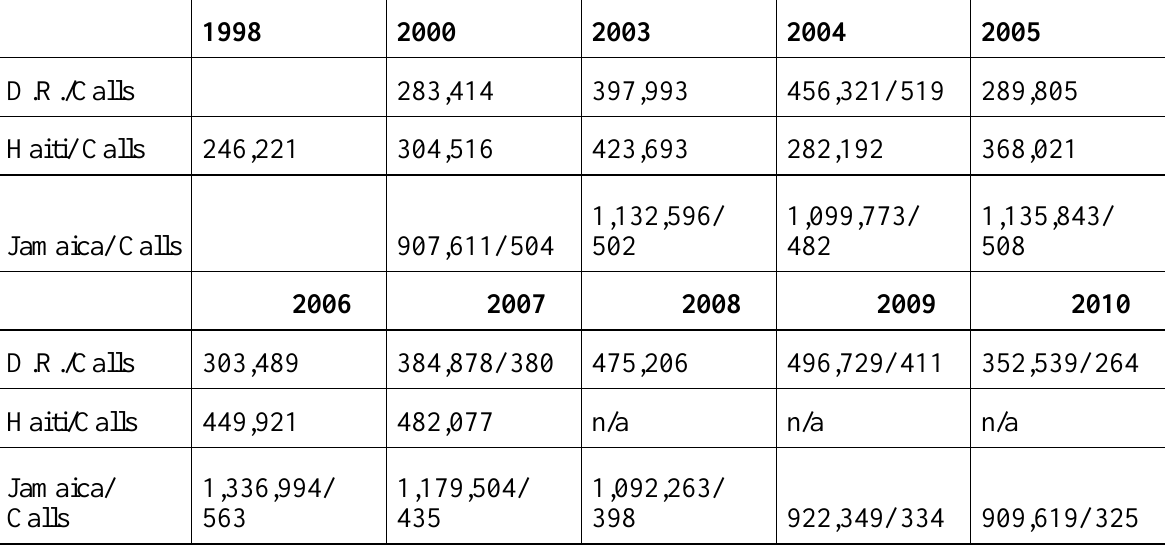
Table 3. Number of Passengers and Calls by Cruise Ships per Year for Dominican Republic (D.R.), Haiti, and Jamaica